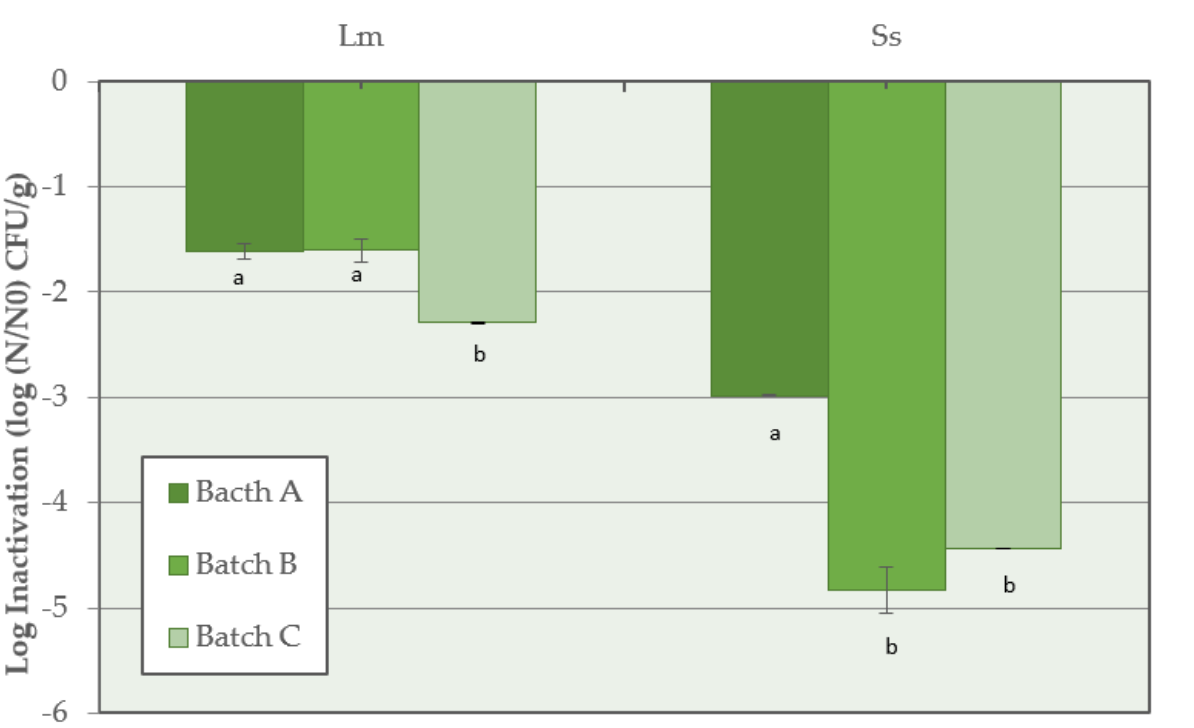
Figure 4. Inactivation of L. monocytogenes (Lm) and Salmonella spp. (Ss) for Batch A (basic recipe), Batch B (vegetable nitrates), and Batch C (synthetic nitrates/nitrites) of Milano-type salami ripened for 70 days. For each pathogen, means with different lowercase letters are significantly different ( p < 0.05).